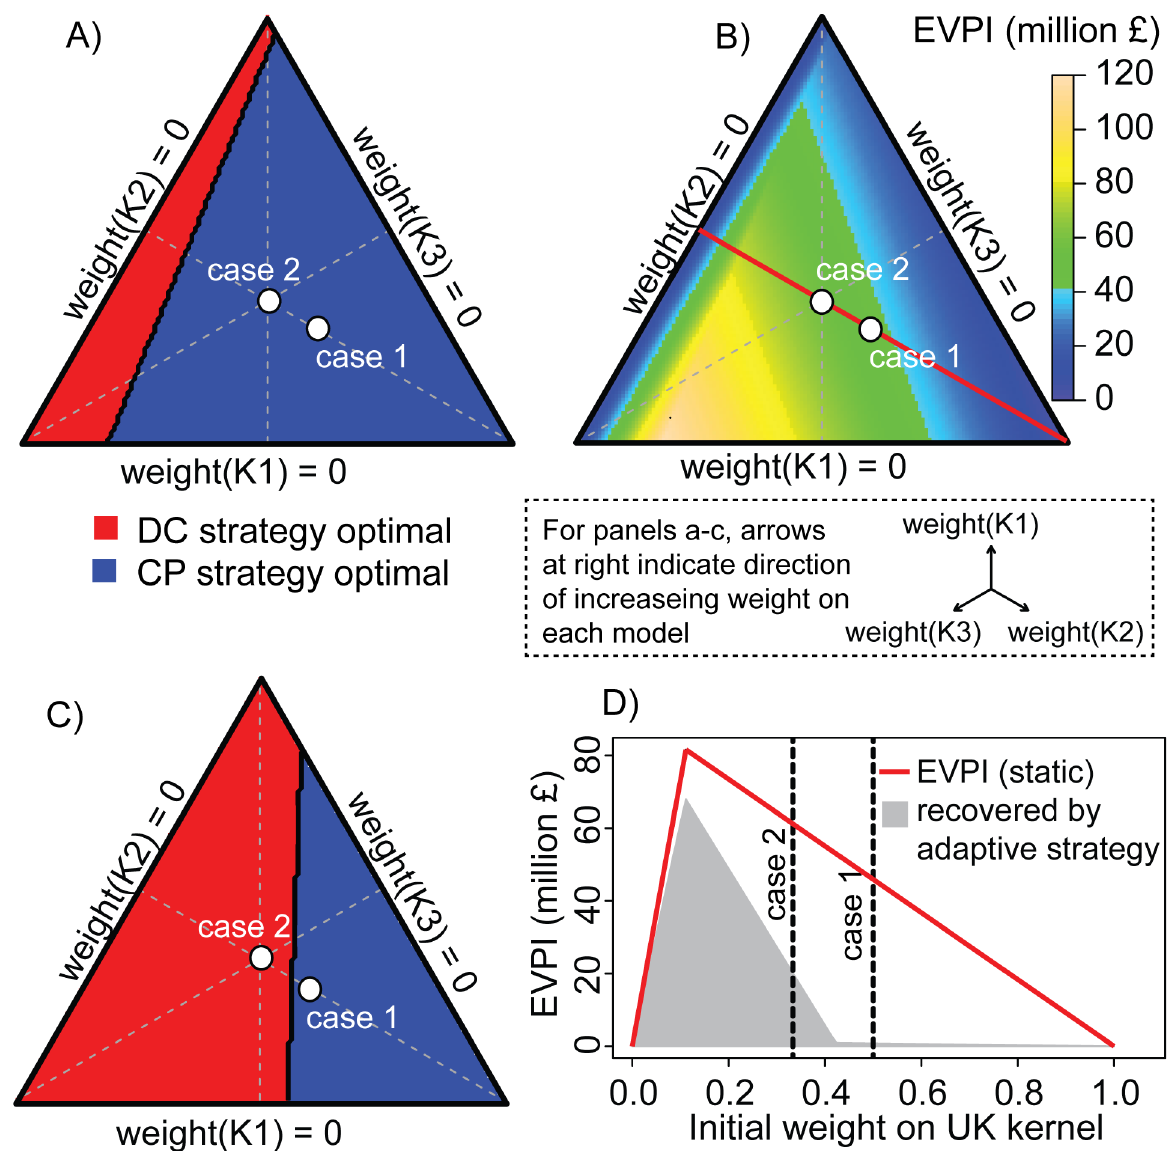
Figure 3. Analysis of the foot-and-mouth case study. (A) The optimal static culling intervention (red, DC; blue, CP) for FMD as a function of the initial weights on the three kernel models. The axes indicate weights on each of the three kernel models and internal points correspond to combinations of weights (summing to 1) on each model; the inset indicates the direction of increasing weight on each model (e.g., the transition from the left axis to the bottom right apex indicates increasing weight on K2 with equal weight on K1 and K3); dots indicate the weight combinations corresponding to case 1 and case 2. (B) The EVPI as a function of the initial weights on the three kernel models; axes and dots are as in (A). (C) The optimal first-stage culling intervention (red, DC; blue, CP) for the two-stage adaptive strategy as a function of the initial weights on the three kernel models; axes and dots are as in (A). (D) The EVPI (red line) as a function of the weight on the UK kernel, assuming equal weights on the other two models. The grey shading indicates the amount of the EVPI that is expected to be recovered under an adaptive